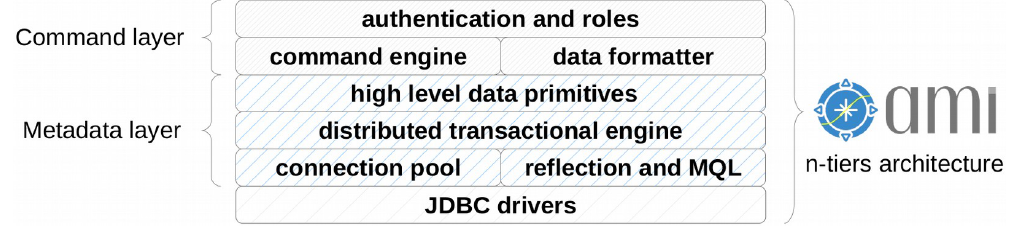
Fig. 1. Overview of the AMI ecosystem.